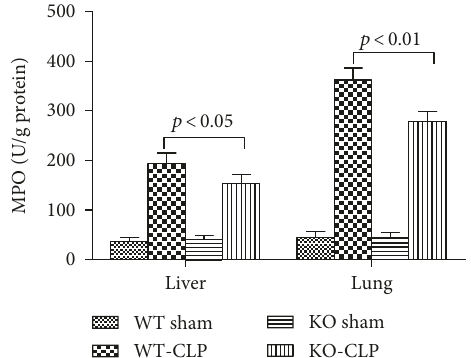
Figure 13: Lack of 5-HT decreases the level of MPO in CLP- induced sepsis. The activities of myeloperoxidase (MPO) in the liver and lung tissues were measured using activity assay kits. All data are expressed as the mean ± SD. p < 0 05 versus the WT-CLP